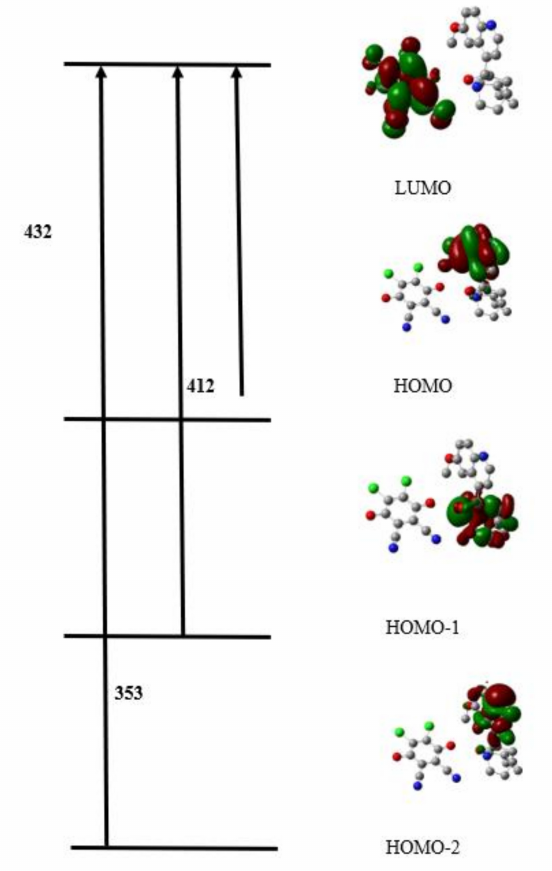
Figure 10. Assignments of theoretical electronic absorption transitions of Quinine → DDQ charge transfer